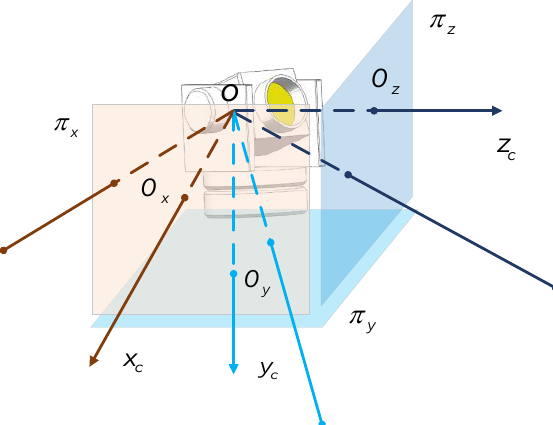
Figure 2. Virtual omnidirectional camera model of MVMS.